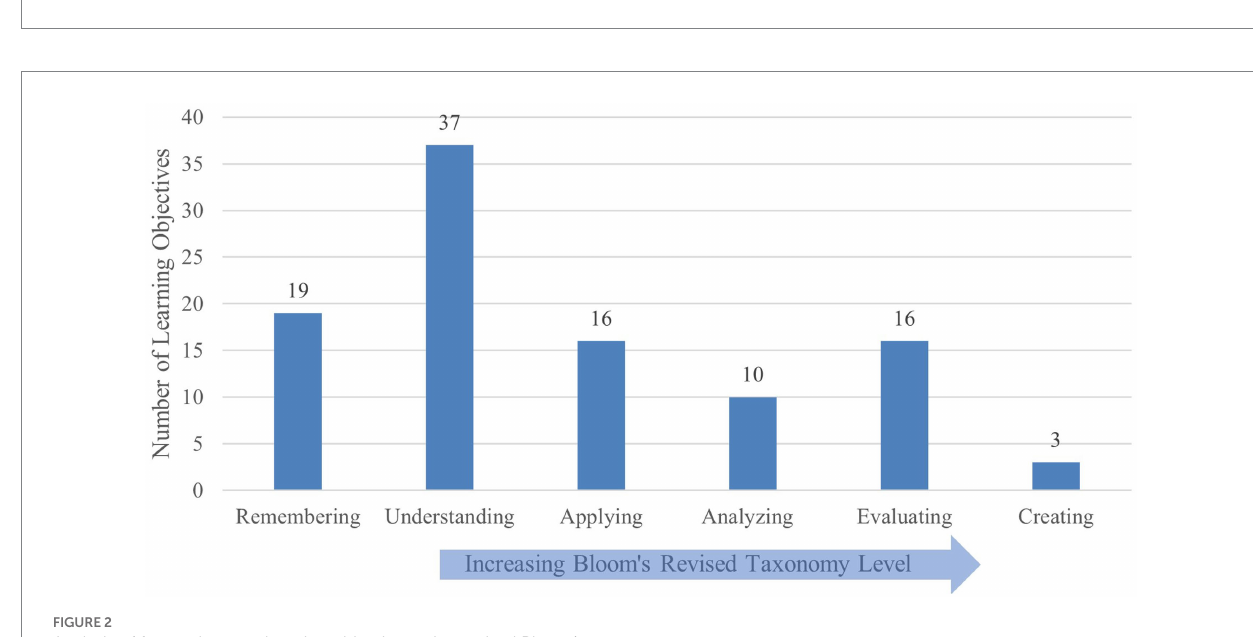
FIGURE 2 Analysis of focused course learning objectives using revised Bloom’s